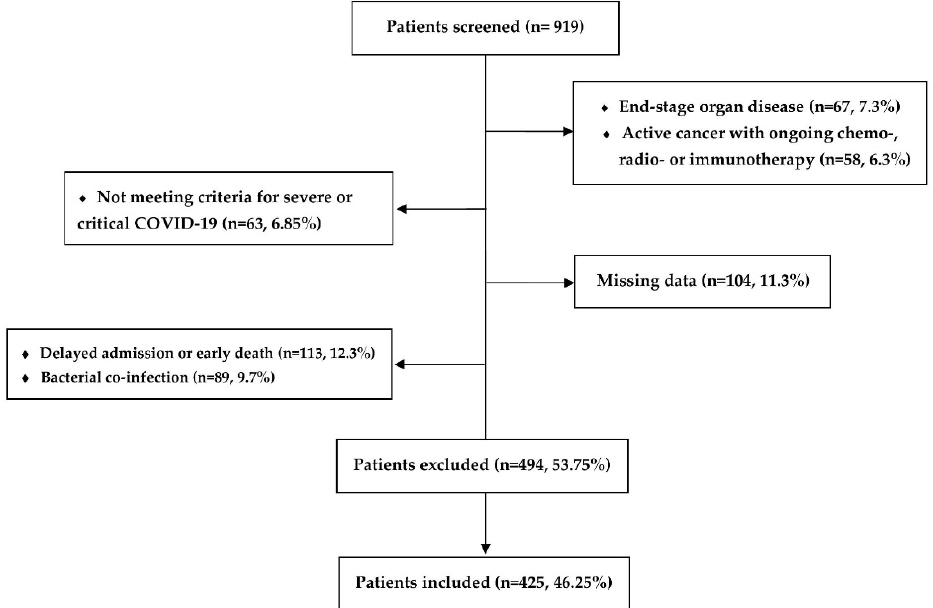
Figure 1. Flowchart of the study population.